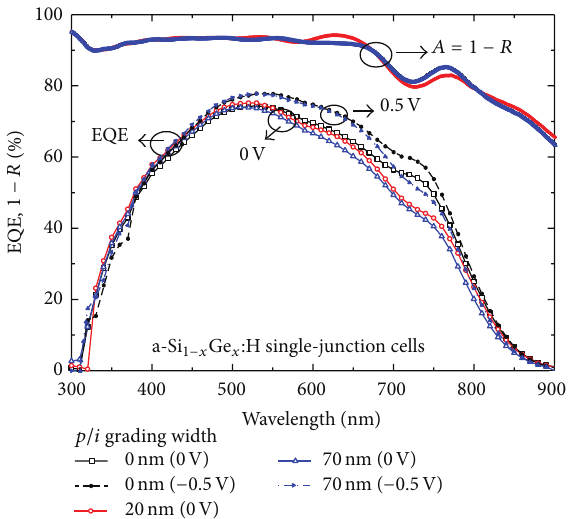
Figure3:Absorptance( 𝐴 )andEQEofa-Si 1− cells measured with 0 V and − 0.5 V biases as a function of the p/i grading width. The p/i grading width was changed from 0 to 70 nm meanwhile keeping the total thickness of the absorber as 230 nm for all the cells.